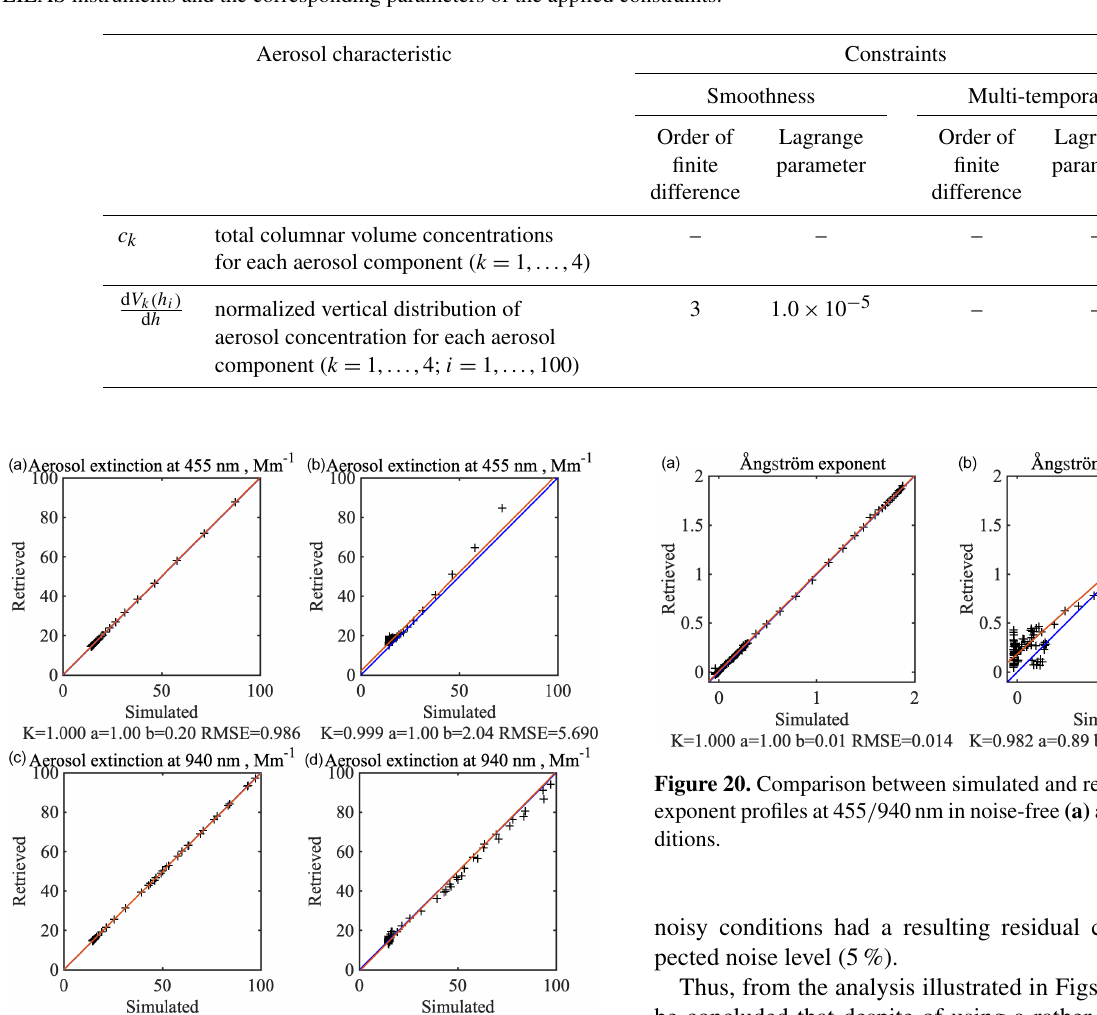
Table 7. Summary of the aerosol properties retrieved and provided by GRASP implying a stand-alone retrieval scheme for COBALD and LILAS instruments and the corresponding parameters of the applied constraints.